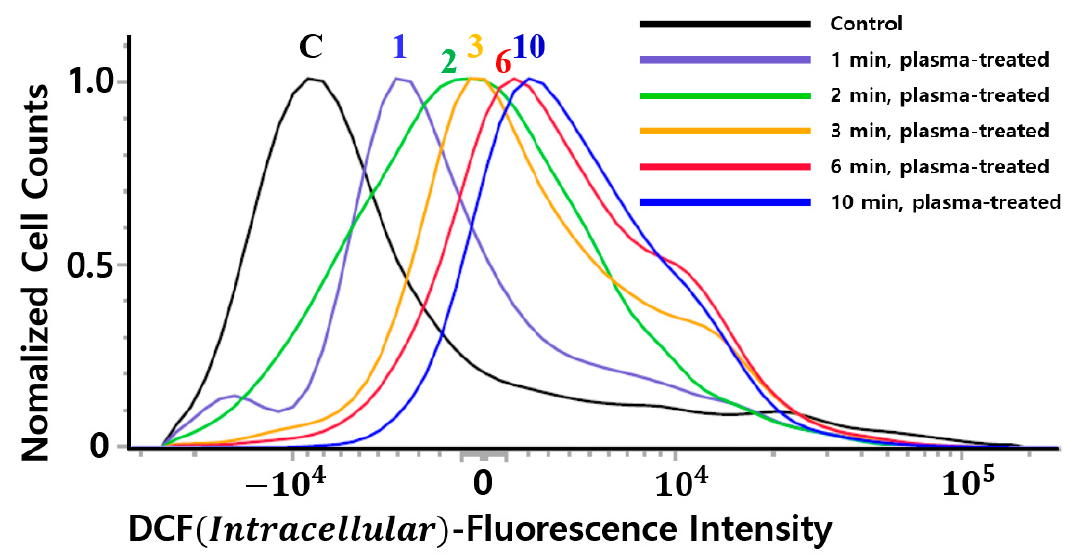
Figure 4. Fluorescence intensity of H 2 DCF - DA -stained C . pruinosa spores for intracellular reactive oxygen species generated by a soft plasma jet. C, 1, 2, 3, 6, and 10 represent intracellular ROS for the control, 1 min, 2 min, 3 min, 6 min, and 10 min plasma-treated C . pruinosa spores, respectively.